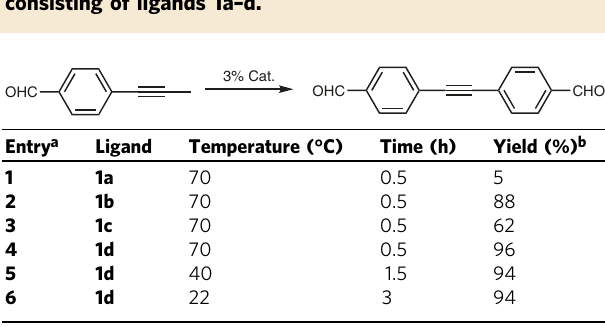
Table 1 Catalytic activities of multidentate catalysts consisting of ligands 1a – d.